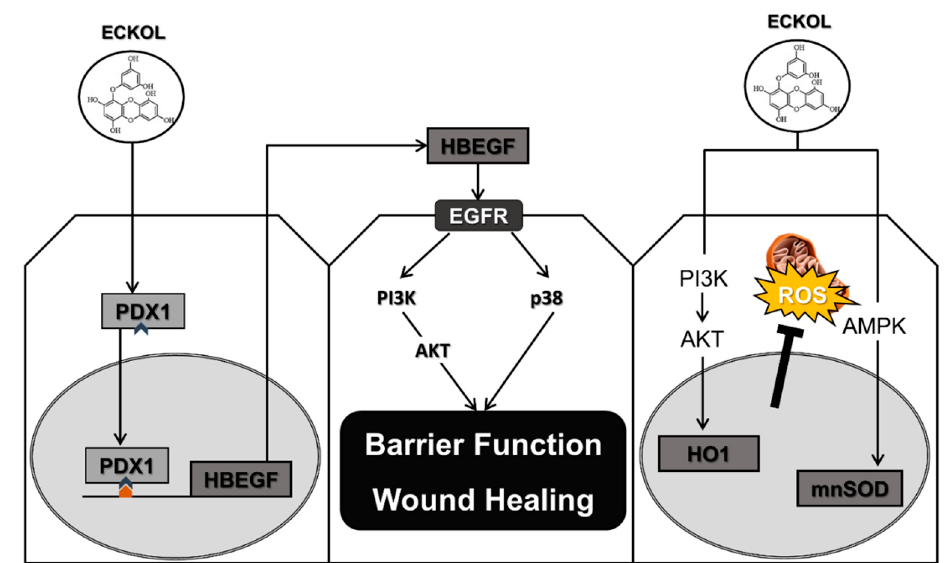
Figure 9. Schematic illustration of the effects of eckol on intestinal development during the suckling-to-weaning transition. Eckol induces PDX1 expression that directly regulates HBEGF expression, leading to enhanced intestinal barrier function, accelerated wound healing, and reduced oxidative stress through the activation of various intracellular signaling pathways.